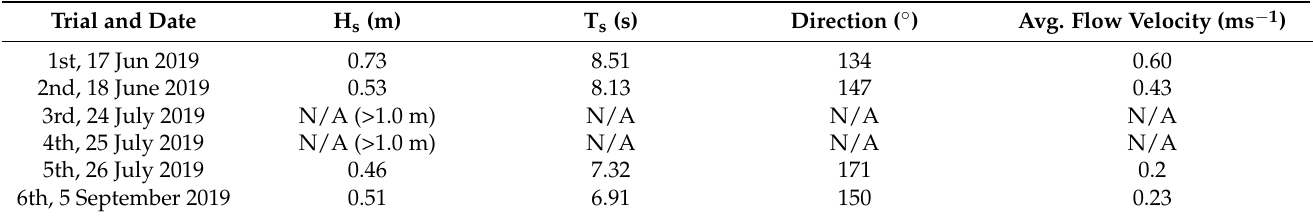
Table 1. Wave conditions of each GPS drifter survey trial.